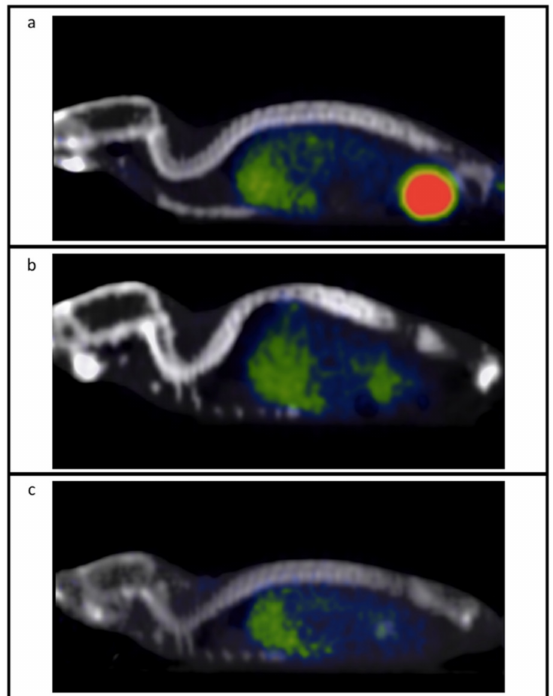
Figure 1. PET/CT images of three mice injected with the 64 Cu-labeled chelator at the three acquisition times via micro-PET/CT (Albira Si micro-PET/CT). ( a ) Mouse scanned 1 h after administration of the radioactive compound; ( b ) mouse scanned 4 h after administration of the radioactive compound; ( c ) mouse scanned 24 h after administration of the radioactive